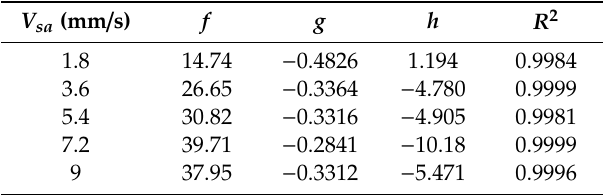
Table 7. The fitted coefficients of the width of sample particle stream W sa versus sample flow velocity V sa at five different sheath flow velocities V sh .